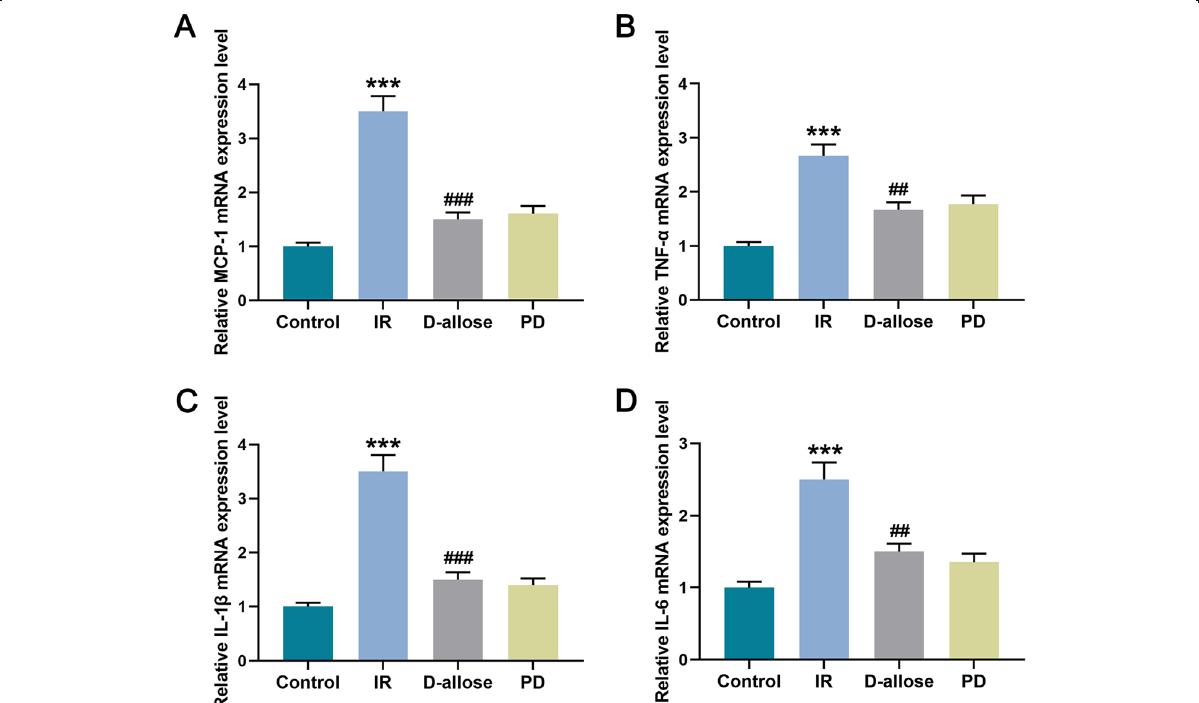
Fig. 4 D-allose decreased inflammatory factors in skin flap injured by I/R. a Relative MCP-1 mRNA expression level in skin flap was measured by RT-qPCR in Control, IR, D-allose and PD groups; b Relative TNF- α mRNA expression level in skin flap was measured by RT-qPCR in each group; c Relative IL-1 β mRNA expression level in skin flap was measured by RT-qPCR in each group; d Relative IL-6 mRNA expression level in skin flap was measured by RT-qPCR in each group. Bars indicated means ±SD. *** P < 0.001 vs. Control; ### P < 0.001, ## P < 0.01 vs.